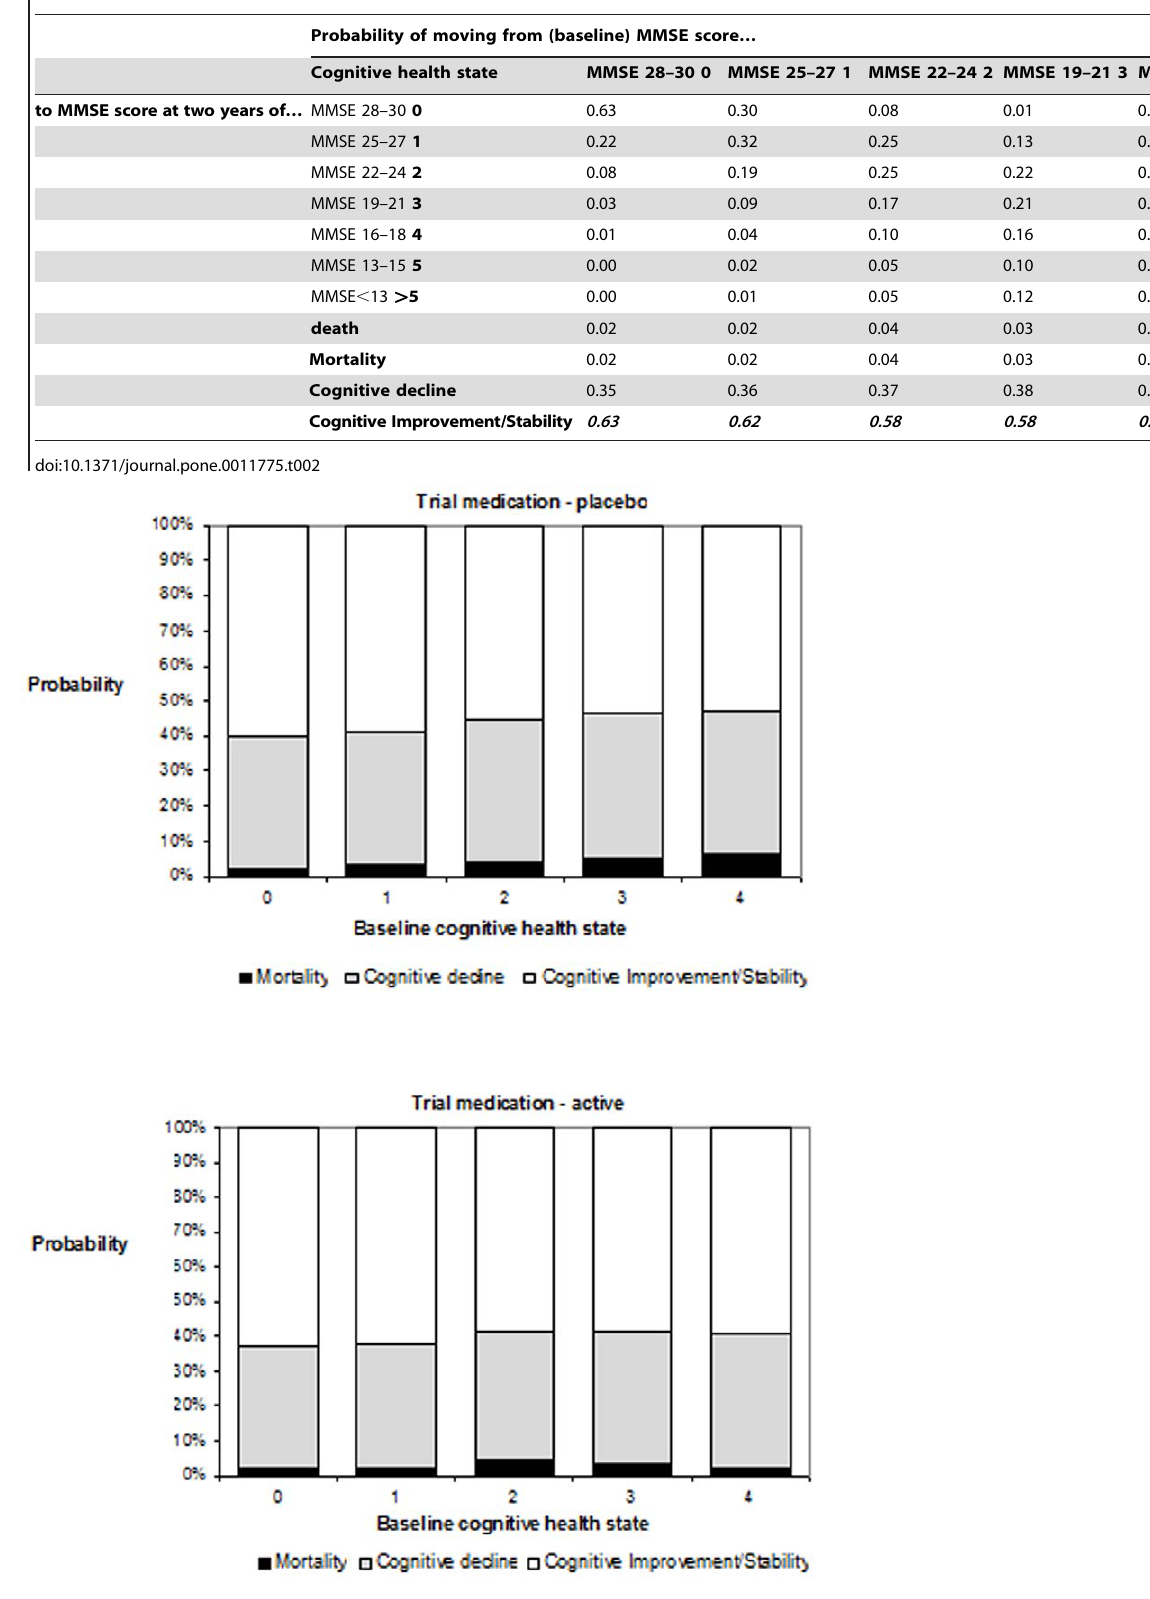
Figure 4. Probability of change over two years by baseline health state. doi:10.1371/journal.pone.0011775.g004 PLoS ONE |